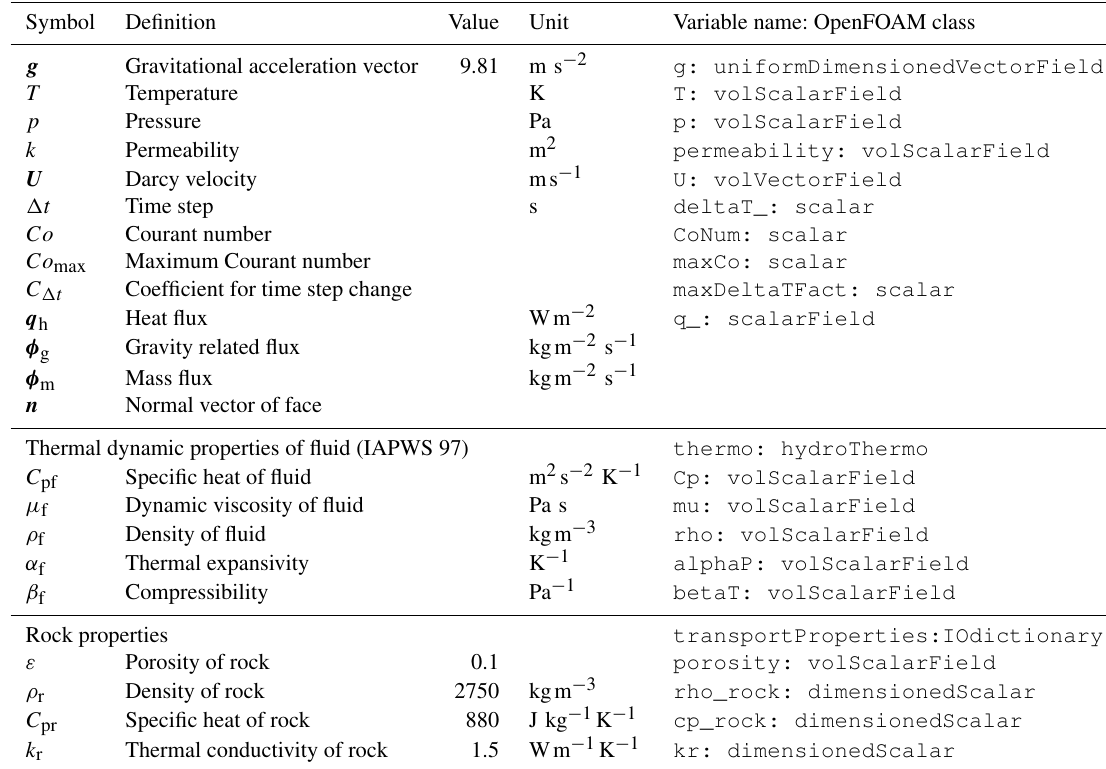
Table 1. Definitions and values of variables used in this